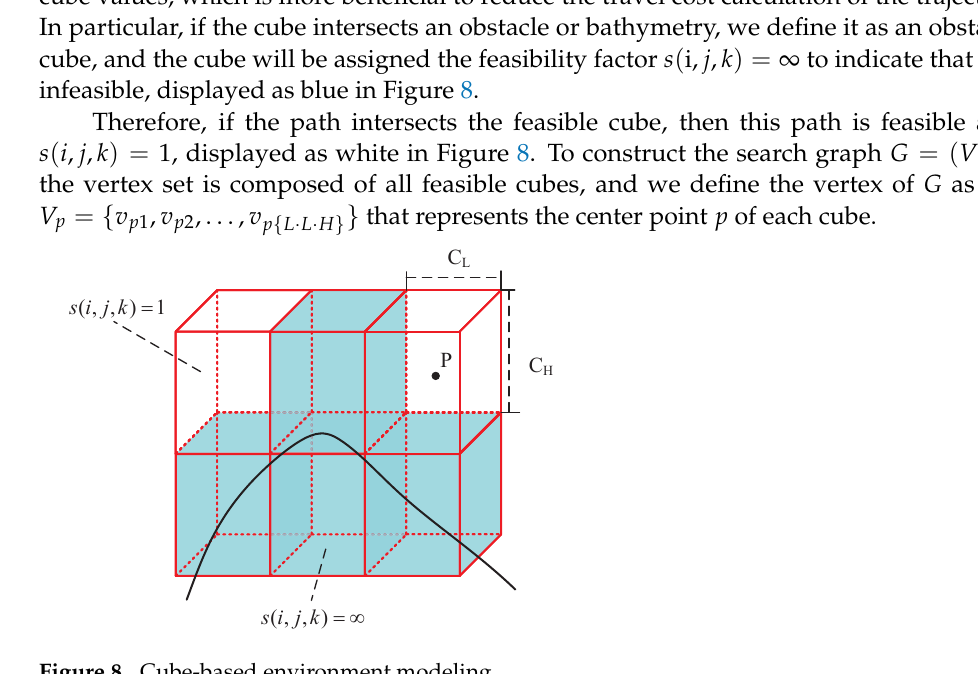
Figure 8. Cube-based environment